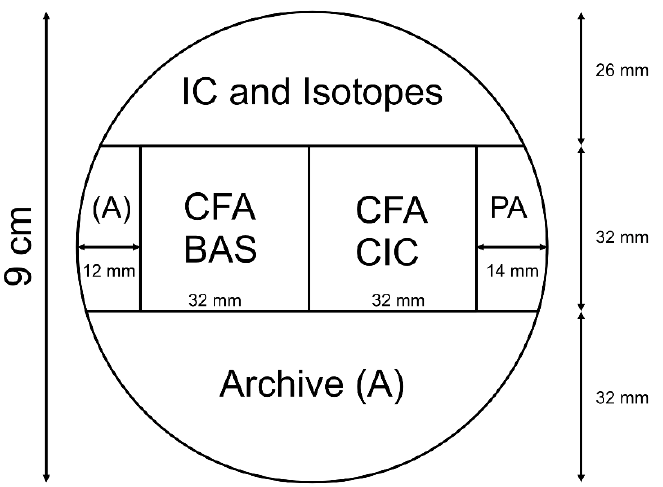
Figure 2. Cutting scheme of a circular Young Island ice core cross section, including square strips for continuous flow analysis (CFA) at the Niels Bohr Institute (former Centre for Ice and Climate, CIC) and the British Antarctic Survey (BAS), segments for discrete ion chromatography (IC) and stable water isotope measurements, microparticle analysis (PA), and an archive (A); figure adapted from [35].